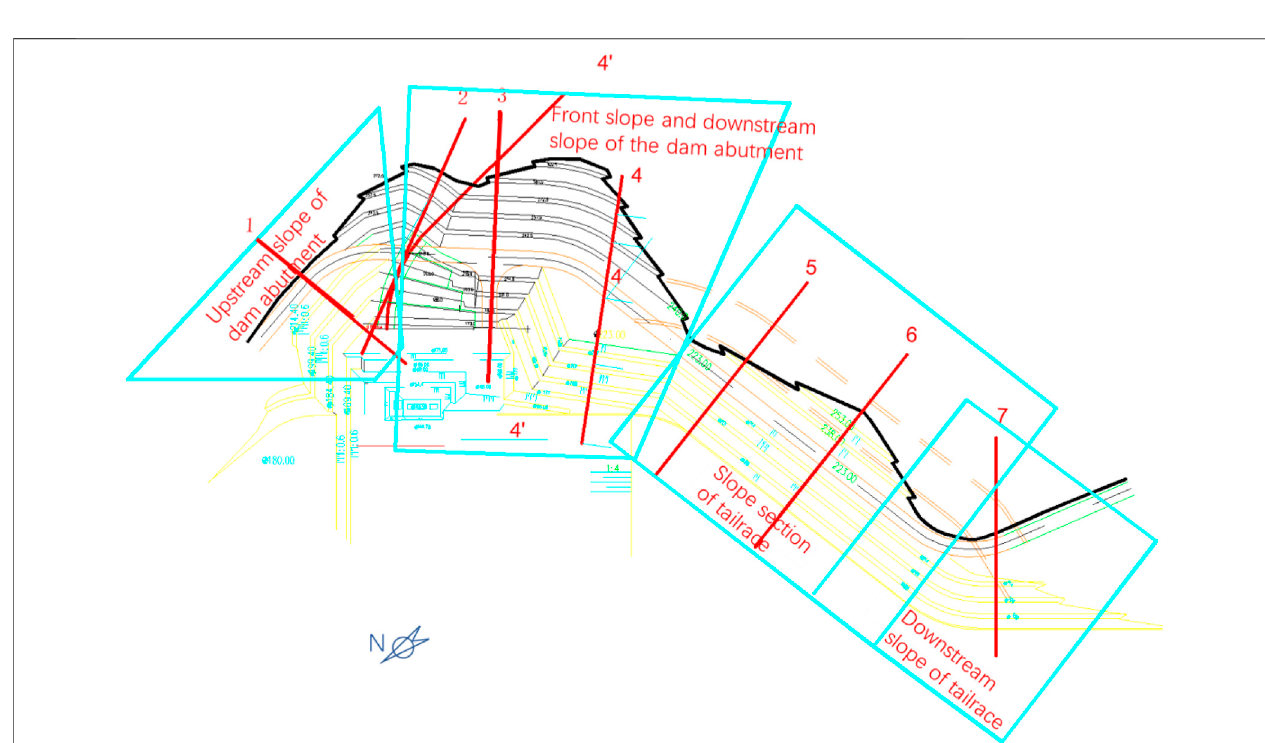
FIGURE 6 | Slope shape and division of the left bank slope.